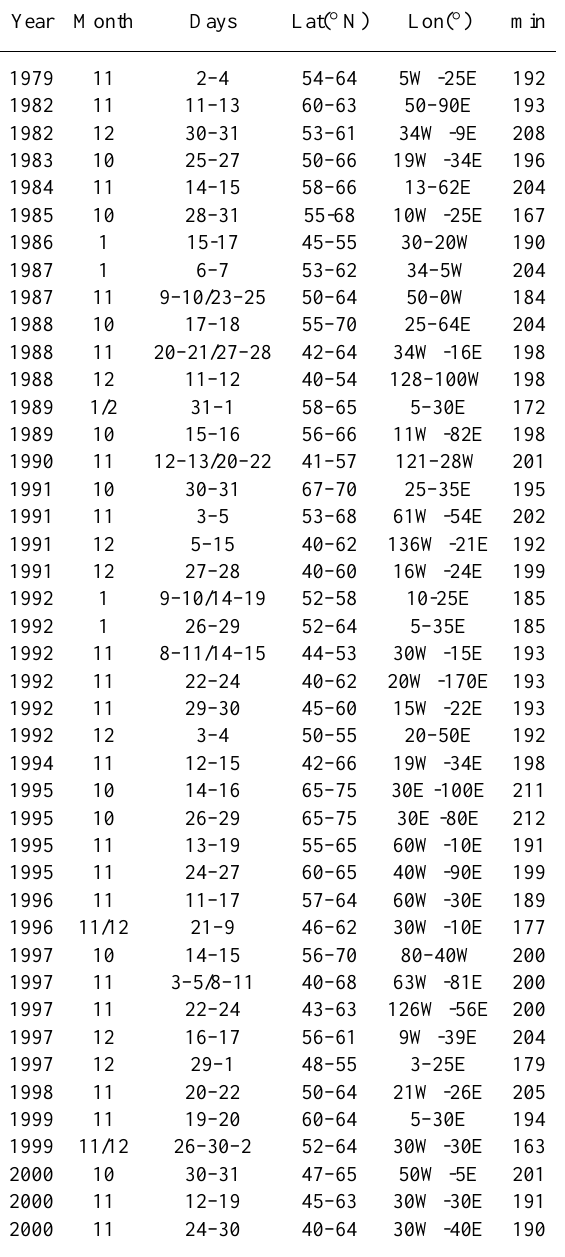
stratosphere at the time of an ELO 3 , the backward trajec- tories at isentropic surfaces of 350 and 380 K were used for all cases since 1992. The ten-day backward trajectories from NILU were used, calculated on the basis of